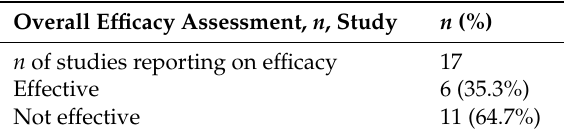
Table 6. Summary of efficacy assessments of NF based treatment in selected